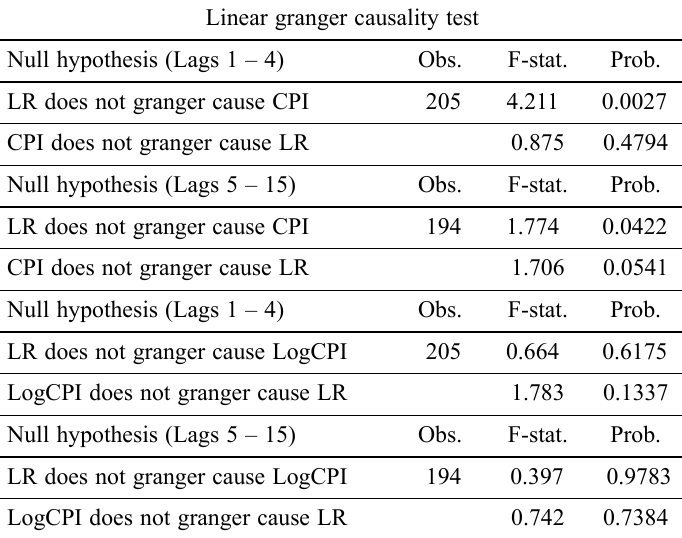
Table 6 . Linear granger causality test (prewhitened series) Linear granger causality